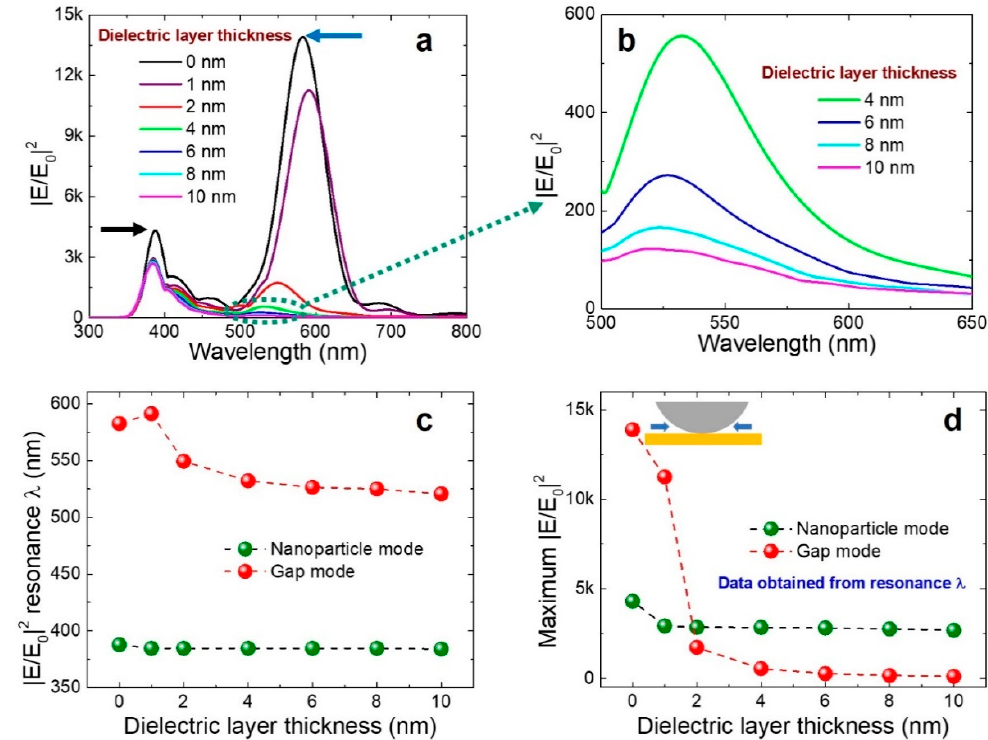
Figure 2. ( a ) Simulated broadband near-field enhancement spectrum as a function of dielectric layer thickness; ( b ) Magnified broadband near-field enhancement spectrum for dielectric layer thickness 4–10 nm. Resonance | E/E 0 | 2 wavelengths “ λ ” ( c ) and respective maximum near-field enhancement ( d ) extracted from ( a ). The inset figure in ( d ) shows the presence of nanogap at both ends (blue arrows) of the metallic contact in the absence of a dielectric layer. The dashed lines are guided for eyes. Zero nanometers describe the absence of dielectric layer.